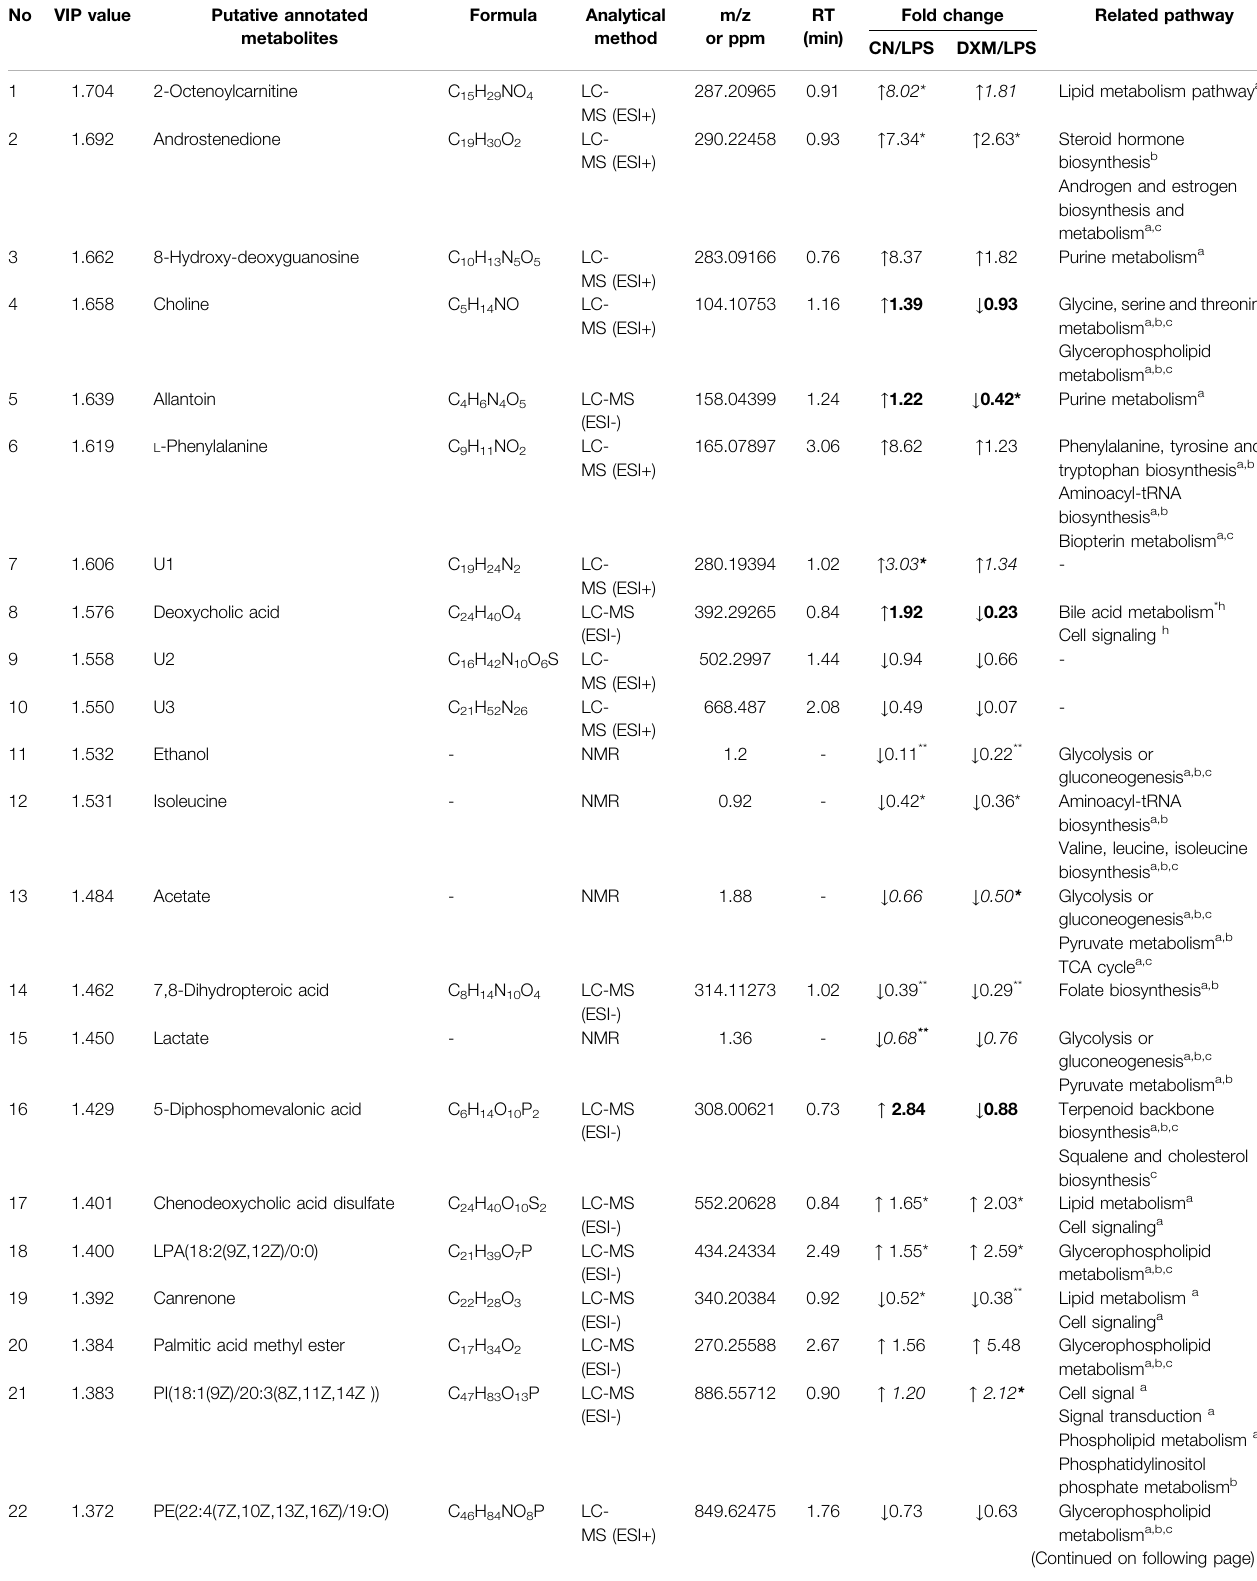
TABLE 1 | Major biomarkers of neuroin fl ammatimeon induced by LPS in rats and their fold change values due to the treatments with CN or